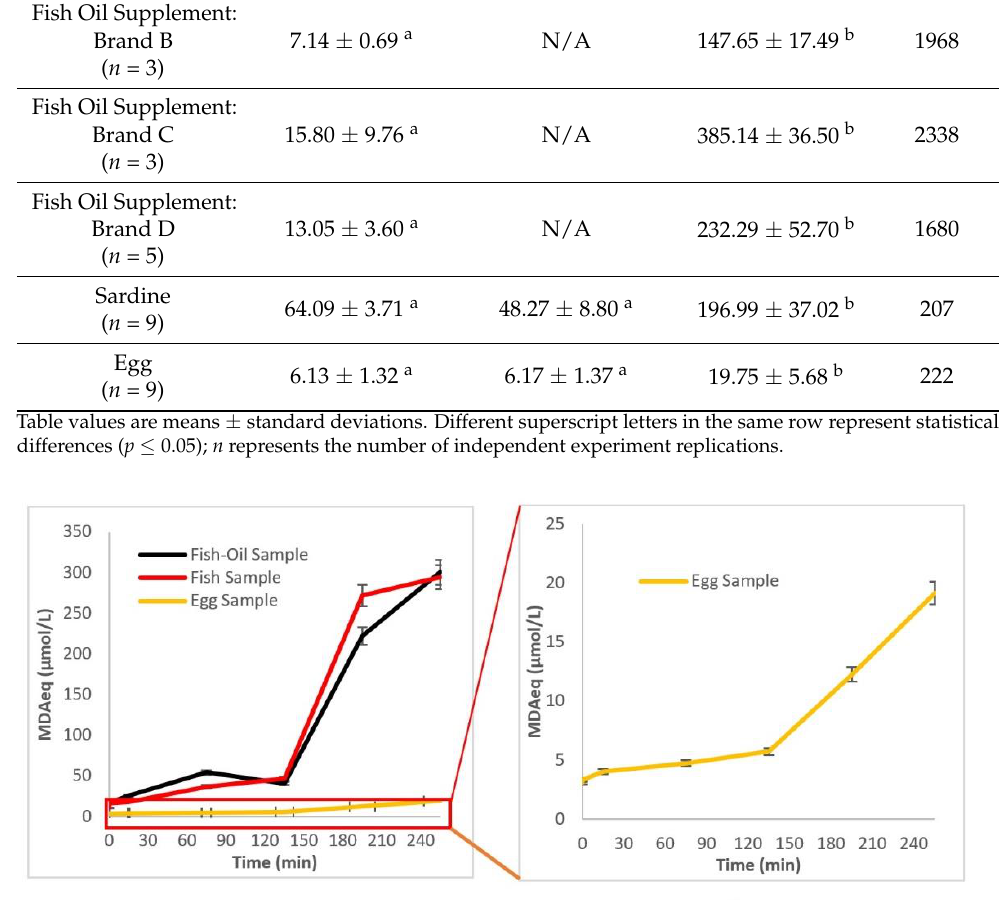
Table values are means ± standard deviations. Different superscript letters in the same row repre- sent statistical differences ( p ≤ 0.05); n represents the number of independent experiment replica- tions.